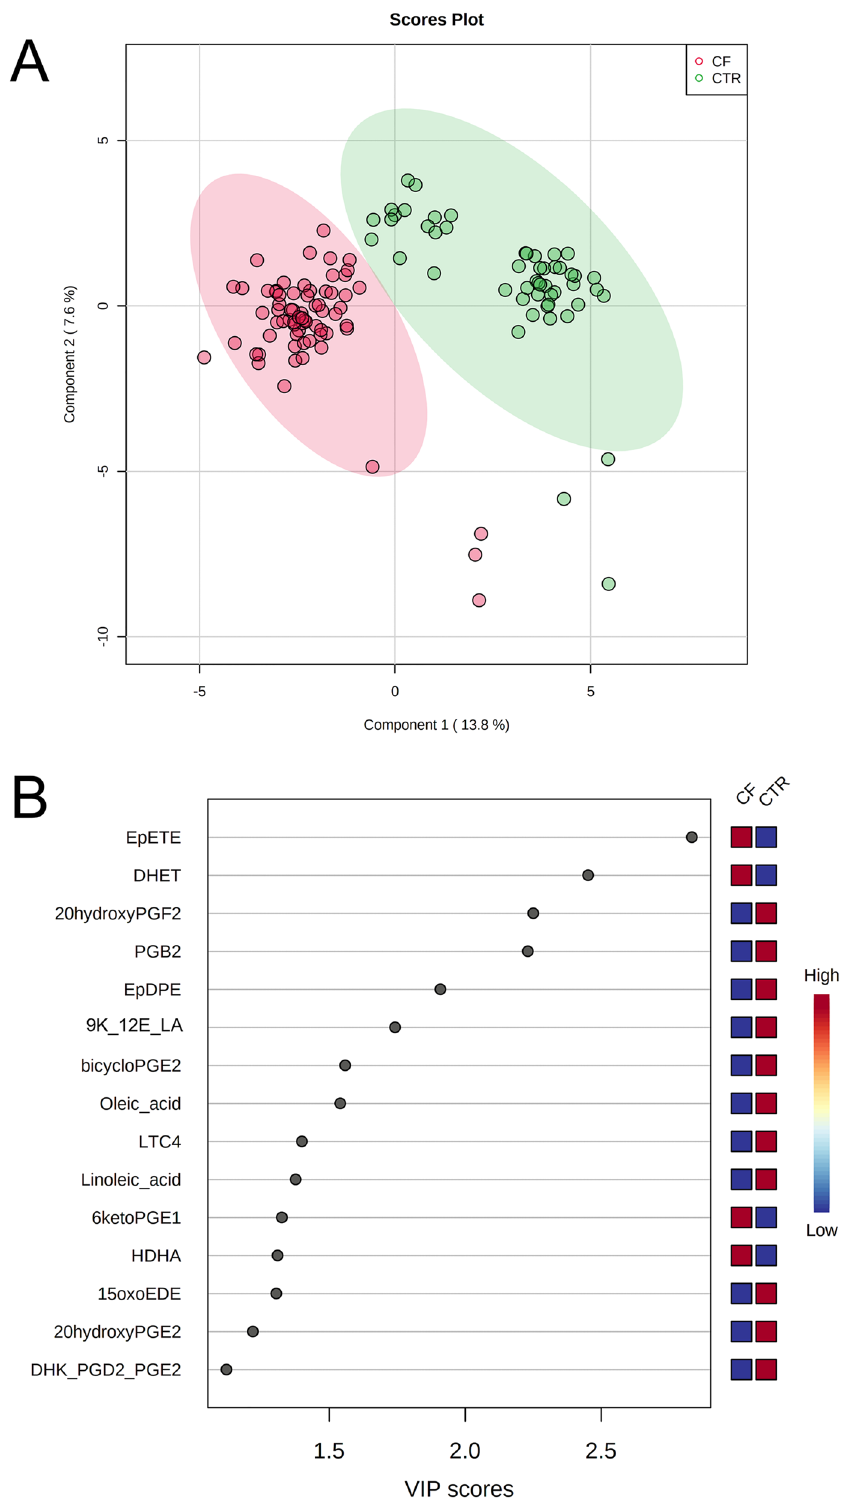
Figure 1. PLS-DA analysis discriminating patients with CF and controls (CTR). ( A ) 2D score plot; ( B ) VIP score of the first 15 features.CF: cystic fibrosis; PLS-DA: partial least-squares discriminant